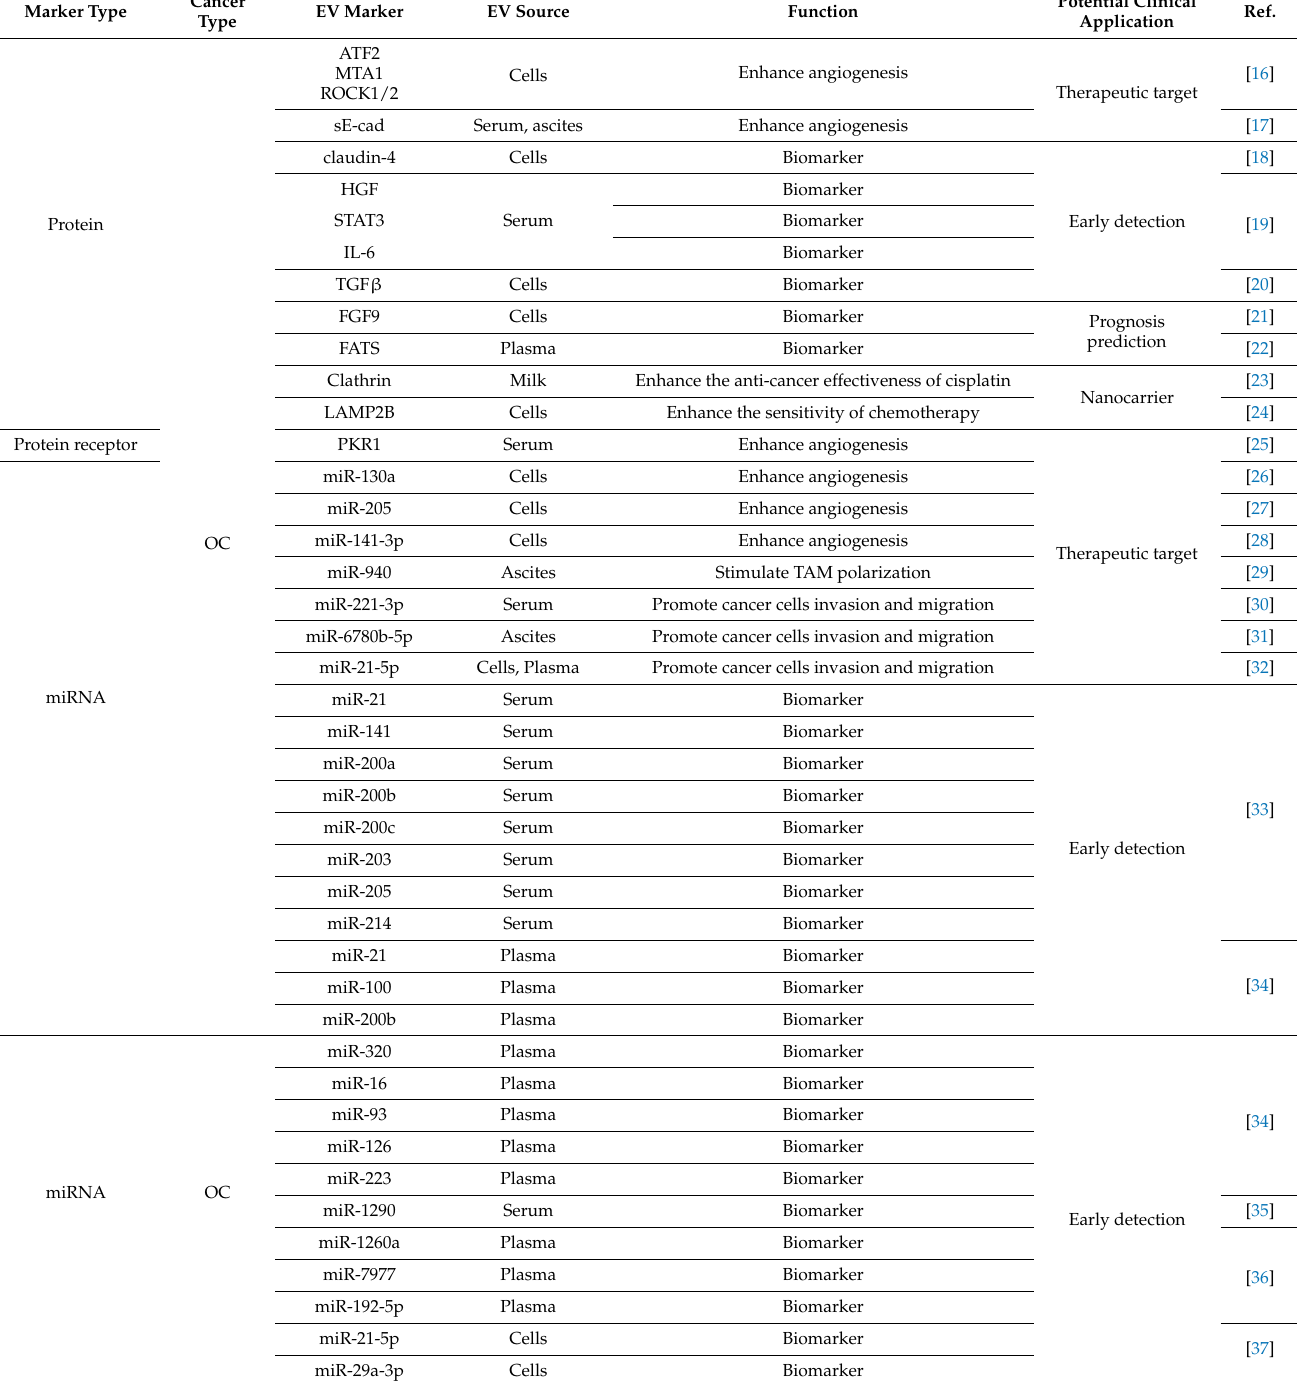
Table 1. Role of EV biomarkers in the gynecologic cancer